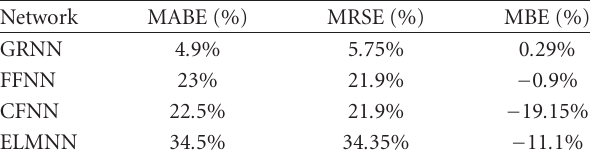
Table 5: Comparison of the proposed